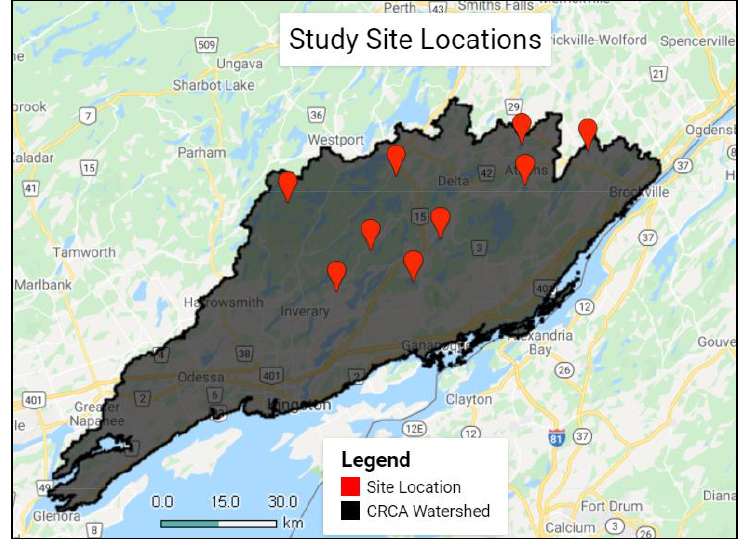
Figure 1. Location of study area and small lakes across the Cataraqui Region Conservation Authority’s watershed.